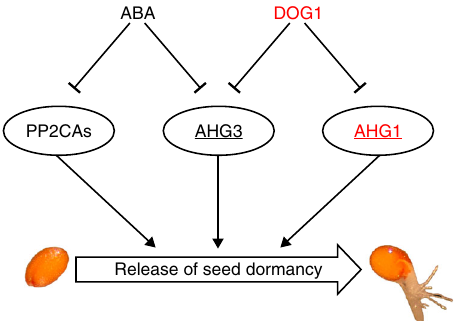
Fig. 5 A model for the roles of DOG1 and ABA in the control of seed dormancy. DOG1 and ABA inhibit the action of distinct and overlapping members of clade A of the type 2C protein phosphatases. These PP2Cs positively regulate the release of seed dormancy and among them AHG1 and AHG3 have major roles. Seed-speci fi c proteins are indicated in red . Clade A PP2C proteins are encircled. Proteins that form a complex with DOG1 in seeds are